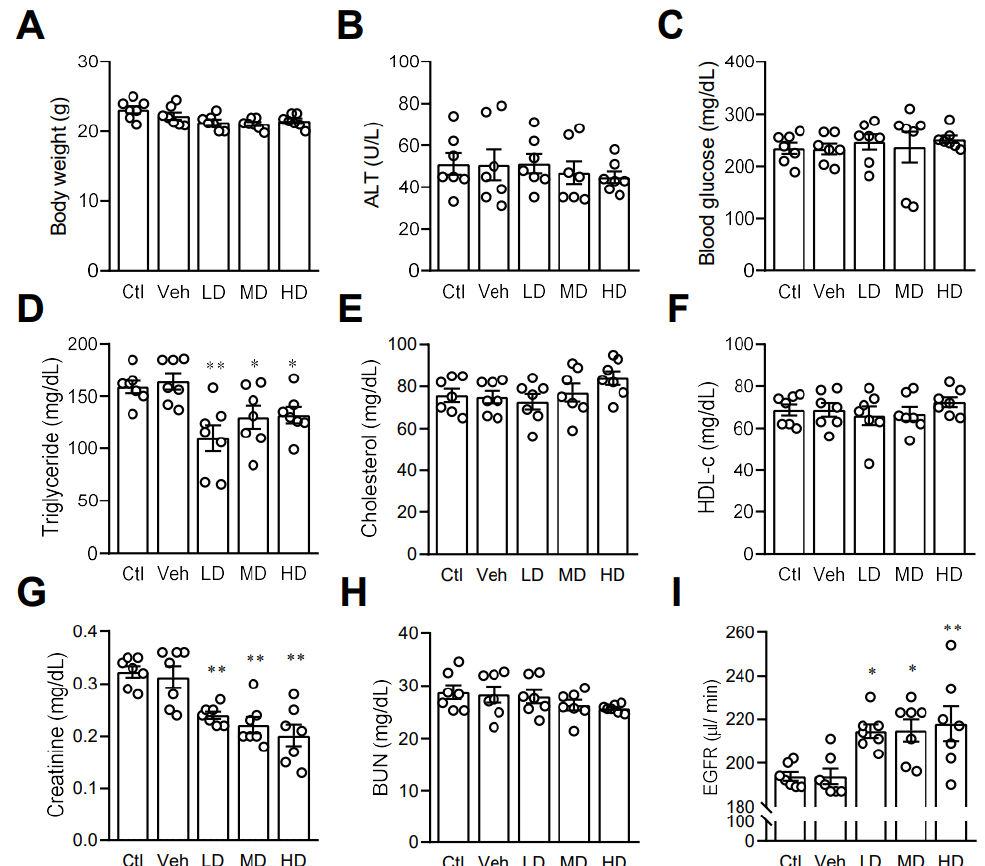
Figure 6. Coral hydrate affects lipid profile and kidney functions in mice. Coral hydrate was administered to mice via oral gavage for 7 days. After overnight fasting, the body weights ( A ) of the mice were recorded, and blood samples were collected for the determination of alanine transaminase (ALT) ( B ), blood glucose ( C ), and lipid profiles. Lipid profiles comprised triglycerides ( D ), total cholesterol ( E ), and high-density lipoprotein-cholesterol (HDL-c) ( F ). In addition, creatinine ( G ) and blood urea nitrogen (BUN) ( H ) were measured. Estimated glomerular filtration rate (EGFR) was calculated using chronic kidney disease epidemiology collaboration equation ( I ). All measurements were made with commercially available kits. Low-dose group (LD), 105 mg/kg coral hydrate; Medium-dose group (MD), 210 mg/kg coral hydrate; High-dose group (HD), 420 mg/kg coral hydrate; vehicle group (Veh) dissolved in 3% carboxymethyl cellulose. Control group (Ctl), 3% carboxymethyl cellulose. N = 7 mice for each group; * p < 0.05; ** p < 0.01 as compared with vehicle group.